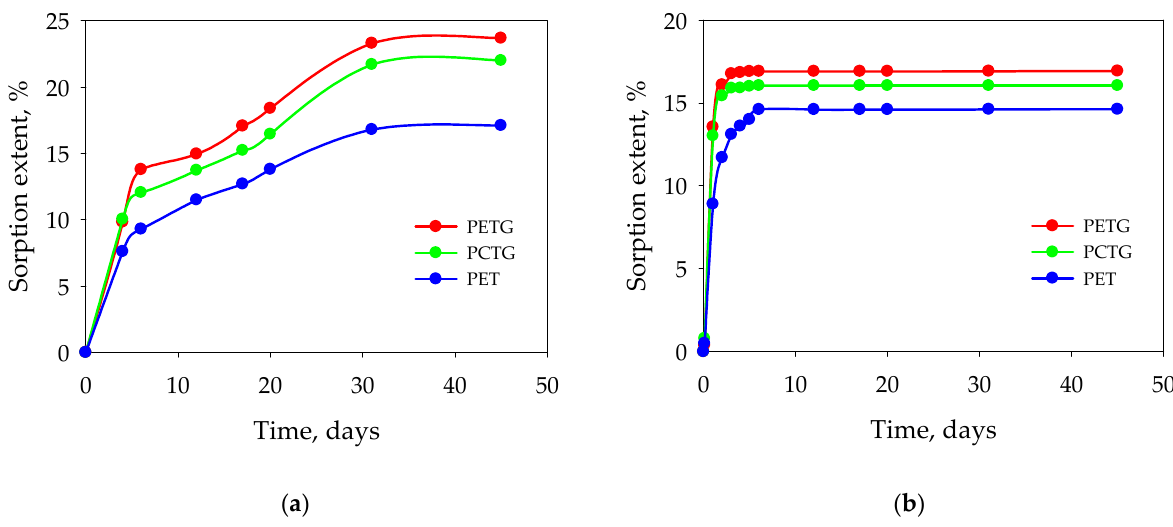
Figure 2. Sorption in the vapor phase: ( a )—ethyl acetate, ( b )—butyl acetate. To describe the influence of the molecular weight of the acetic acid ester, the acetic acid ester with a higher molecular weight such as butyl acetate was used for comparison (Figure 2b). Butyl acetate exhibits different kinetics and extent. The sorption of butyl ace- tate has a two-step equilibrium behavior, the sorption rate is lower compared with ethyl acetate, but the maximum sorption extent at equilibrium is much higher. Butyl acetate has a higher molecular weight than ethyl acetate; however, both have a high maximum sorp- tion degree. This observation may be related to molecular conformation and compatibil- ity. Due to the condensation production process, polyesters are known for their affinity for water vapor sorption [48]. The influence of initial water content in polyester was stud- ied in the vapor sorption of ethyl acetate and polyester samples in the ambient and dried conditioned state. The water content was determined by weighing the samples before and after the vacuum-drying process at 40 °C and 10 mbar pressure, and it was 0% and 0.32%. Dried samples show higher maximum sorption and sorption rate: for PETG by 15%, for PET by 1.6%, and for PCTG by 3.5% higher than for standard samples. These results can be explained by the higher affinity of the solid molecular structure of the polyester for the smaller water molecules and the same type of polar intermolecular interaction. The increase in the maximum sorption range for dried samples is significantly higher than the water content in conditioned samples. Thus, water has some simultaneous sorption with polyesters and influences the extent of sorption of acetic acid esters. The rate and extent of sorption are the highest in the first 24 h of the sorption process (Figure 3). There is little change with respect to sample weight during the first two hours, and the rapid mass transfer begins after this induction period. This behavior can possibly be explained by the surface penetration of acetic ester.